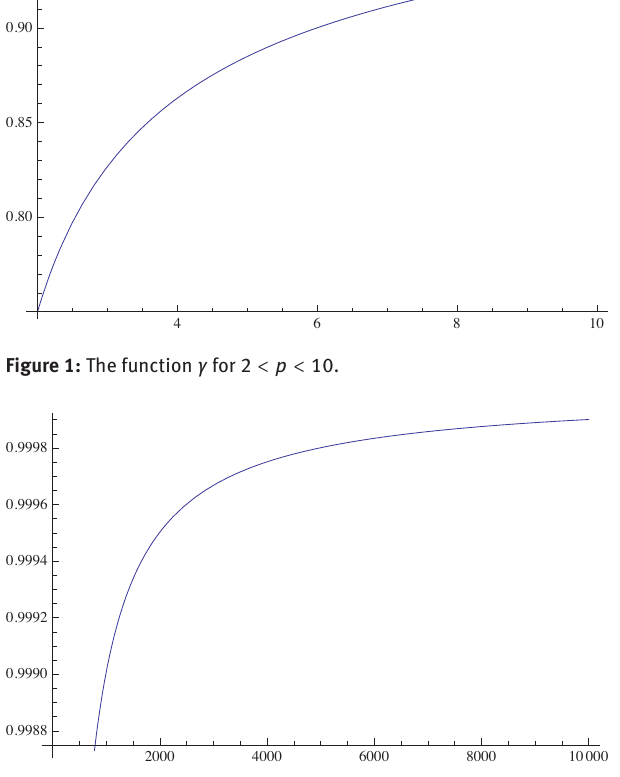
Figure 2: The function γ for 2 < p <